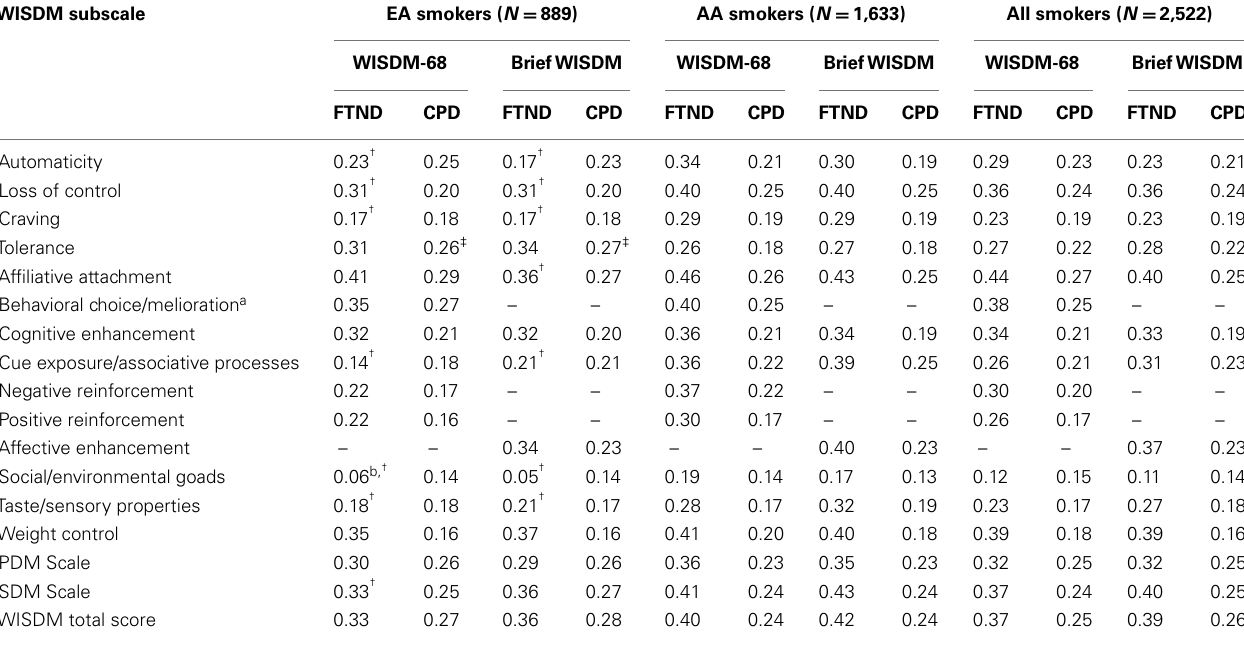
Table 3 | Correlations betweenWISDM-68 and BriefWISDM subscales and with validity measures. WISDM subscale